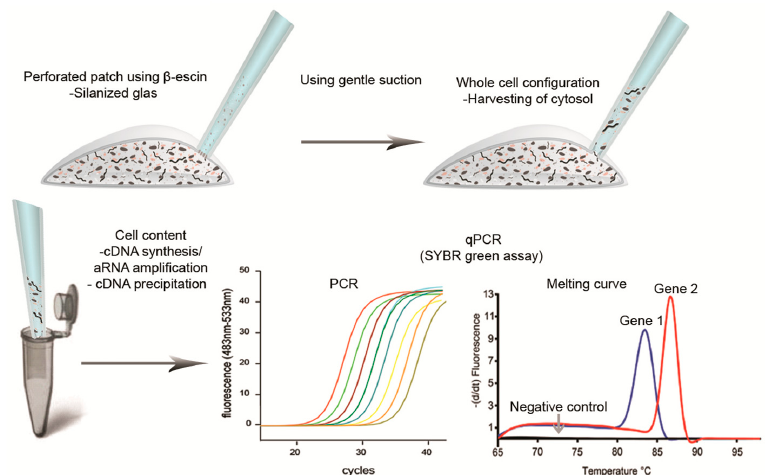
Figure 6. Schematic overview of the protocol used in our laboratory when performing perforated patch-clamp experiments followed by single-cell qPCR. This procedure allows for using perforated patch-clamp recordings and minimizes the incidents of false positive results during gene analysis.The patch pipette is silanized by briefly exposing the tip of the glass in a 1/10 dilution of Sigmacote. To allow for a tight high-resistance interaction between the glass and cell membrane, called a gigaohm seal, the glass tip needs to be fire polished using a microforge. ( Upper left ) The pipette is filled with an RNase-free solution suitable for the experiments and using β -escin to perforate the cell membrane; ( Upper right ) the cell cytosol can be harvested following transition to whole cell configuration using gentle suction; ( Lower left ) the cell content is transferred to a 0.5 mL tube containing RNA stabilizing solution; ( Lower middle figure) the target genes are amplified using qPCR (colored curve represents target gene been amplified); ( Lower right ) following qPCR amplification a melting curve analysis is performed by gently heating the PCR product(s) from 65 to 98 °C while continually reading of the fluorescent (The curve(s) are plotted as the negative 1. derivative of fluorescent with respect to temperature).